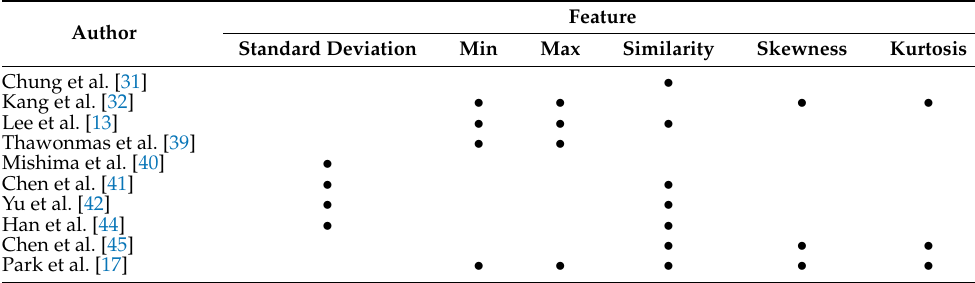
Table 2. Summary and analysis of applicable